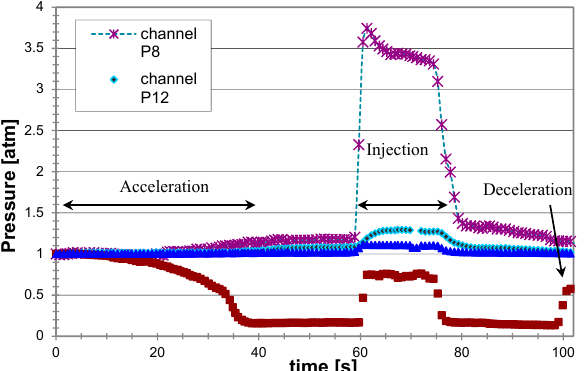
Figure 8. Typical pressure readings from the MRJ propulsor driven by boiling butane, at 15 m / s (see locations of measurements in Figure